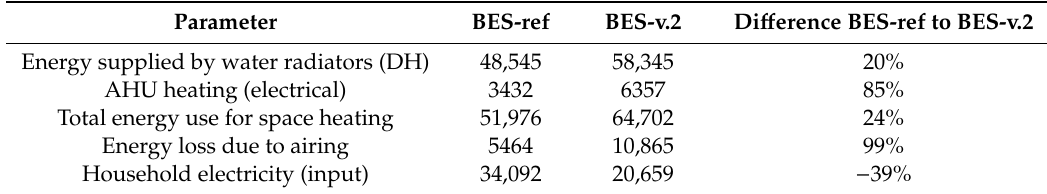
Table 10. Simulated values for a whole-year simulation at building level from BES-ref and BES v.2, and di ff erence in percentage between them (unit KWh). Parameter BES-ref BES-v.2 Di ff erence BES-ref to BES-v.2